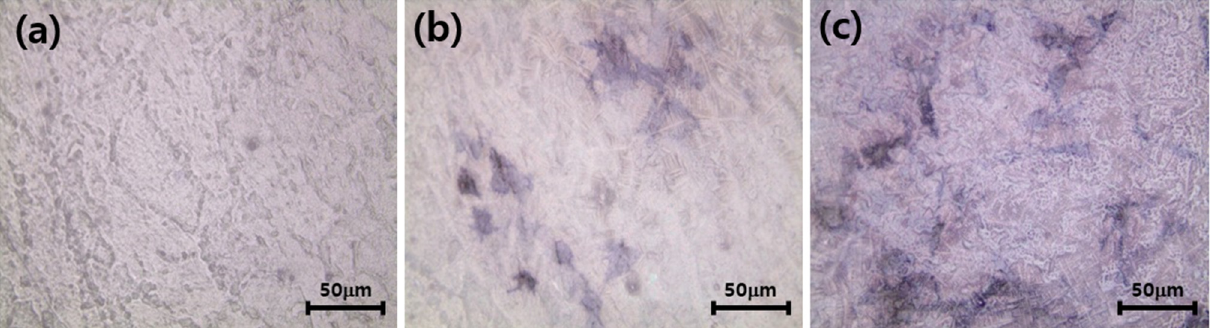
Figure 11. Alkaline phosphatase activity of MC3T3-E1 cells cultured on ZrO 2 ( a ), ZrO 2 -HA ( b ) and ZrO 2 -HA-Col ( c ). After culturing the cells for 21 days, the cells were stained with Fast Blue RR salt and naphthol AS MX phosphate alkaline solution, and a purple image showing ALP activity was observed under an optical microscope.